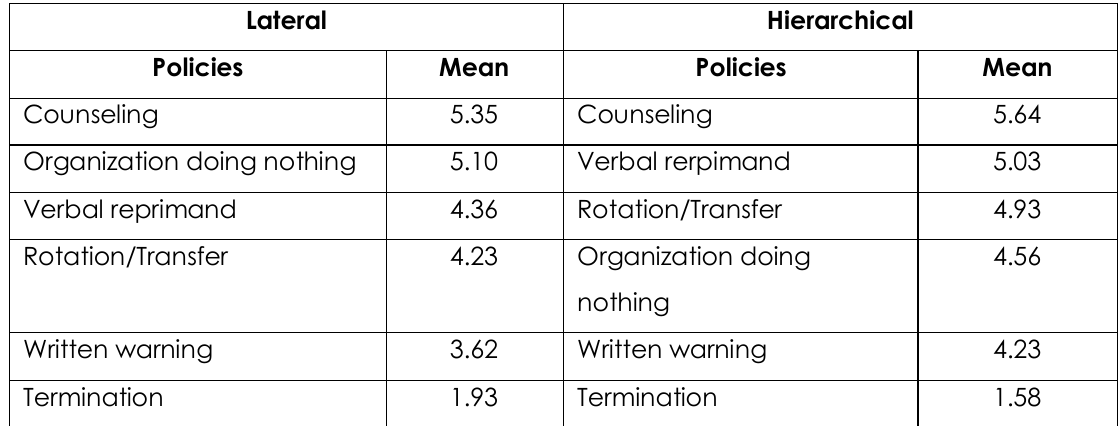
Table 5. Rank of Romance Policies based on Type of Relationship